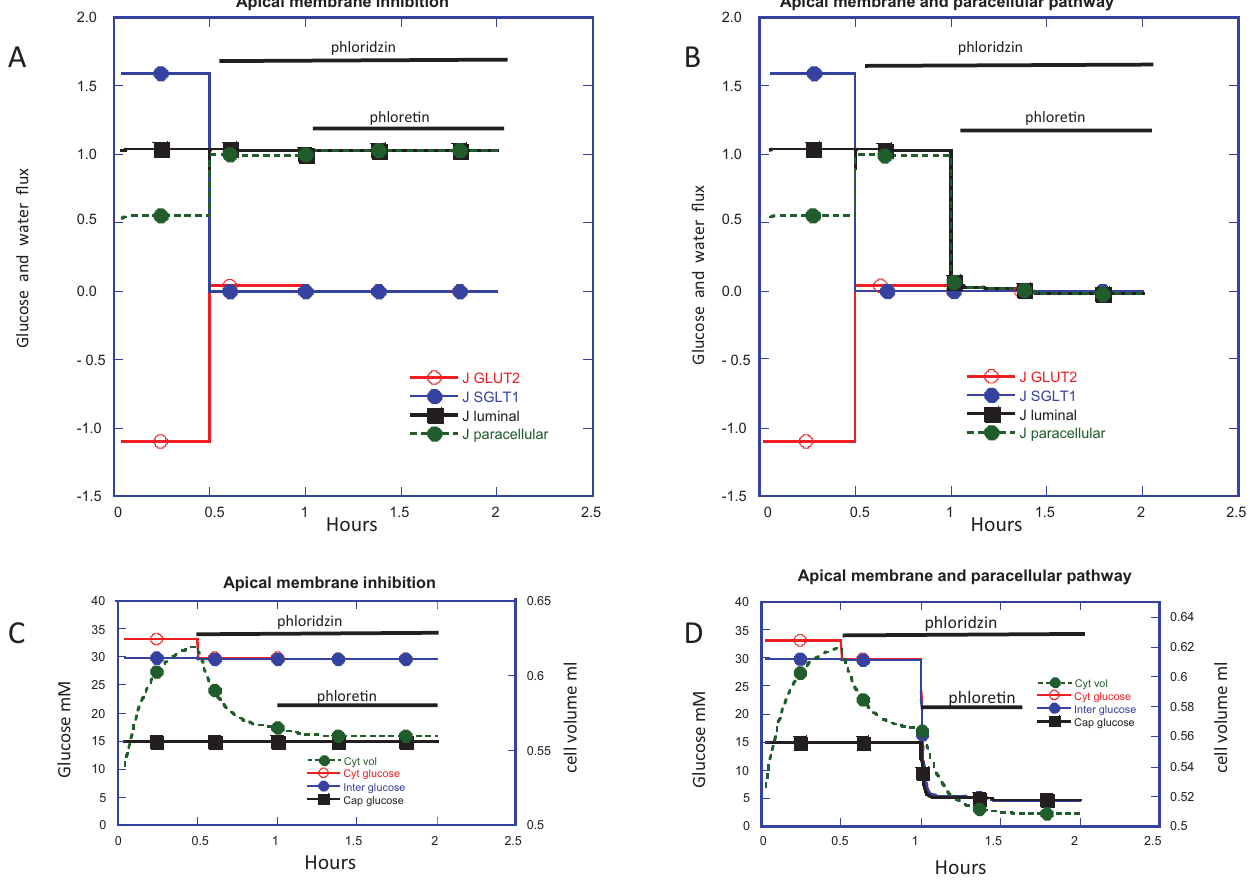
Figure 4. Simulation of sequential additions of phloridzin then phloretin to the luminal fluid on intestinal glucose fluxes. GLUT2 is present in the apical membrane V max 2 and the capillary perfusion rate = 10 is similar to that shown in Figure 2 panels B and D . The luminal glucose is 30 mM and afferent capillary glucose is 5 mM to simulate the conditions used by Kellett & Helliwell 2000 1 . In Figure 4, panels A and B inhibition of SGLT1 activity at 0.5h to zero reduces glucose flux via SGLT1 to zero. Simultaneously glucose flux via GLUT2 increases thereby reversing the backflux from -1.1. to 0.05 and also paracellular glucose flux increases from 0.55 to 0.95. In panels C and D the glucose concentration changes in the cytosol (red) interstitial fluid (blue) capillary fluid (black) and cytosolic volume (green). Following phloridzin addition and inhibition of SGLT1, cytosolic glucose falls from 33 to 30 mM; cytosolic volume falls from 0.62 to 0.56 ml at 1 hour without significant changes in capillary or interstitial fluid glucose concentration. This explains both the fall in glucose reflux via GLUT2 and the decrease in basolateral membrane flux is compensated by the rise in paracellular flux thereby nullifying interstitial glucose concentration changes. Phloretin addition at 1h is simulated by blocking apical GLUT2 (panel A ) and by blocking both apical GLUT2 and paracellular glucose and Na permeability (panel B ). GLUT2 fluxes fall to zero in both panels A and B and in panel A there is a small increase in paracellular glucose flow but the total transluminal glucose flux is unaffected by addition of phloretin after phloridzin. There is a small decrease in cytosolic volume from 0.56 to ≈ 0.55. the paracellular flux falls to zero as does the transluminal glucose flux in panel B , simulating the effect observed by Kellett and Helliwell 2000 1 . This is accompanied by a large decrease in cell volume from 0.56 to 0.51 ml. Since no net glucose transport now occurs from the luminal fluid, capillary glucose concentration also decreases to 5